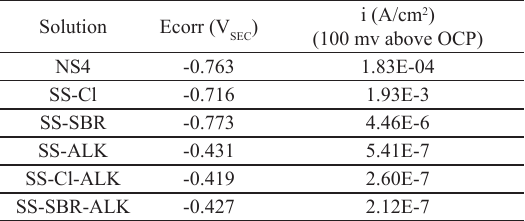
Table 7. Electrochemical parameters determined in synthetic solutions.